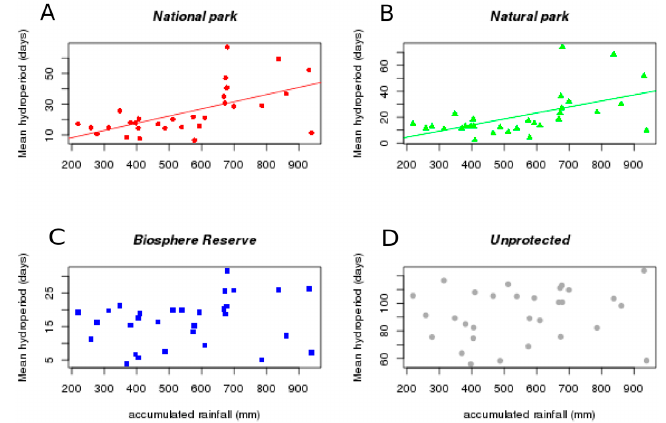
Figure 5. Relationship between annual accumulated precipitation and mean pixel hydroperiod for each level of protection. ( A ) Red circle = National Park; ( B ) green triangles = Natural Park, ( C ) blue squares = Biosphere Reserve, ( D ) gray circles = unprotected. Only statistically significant trend lines are shown.